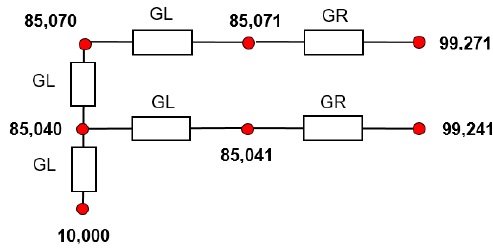
Figure 3. The 7 nodes model.